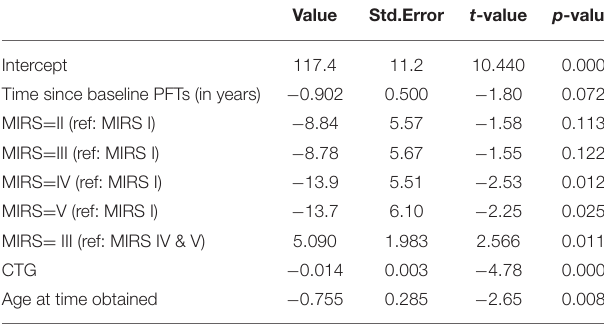
TABLE 3 | Multiple regression of change in FVC (%